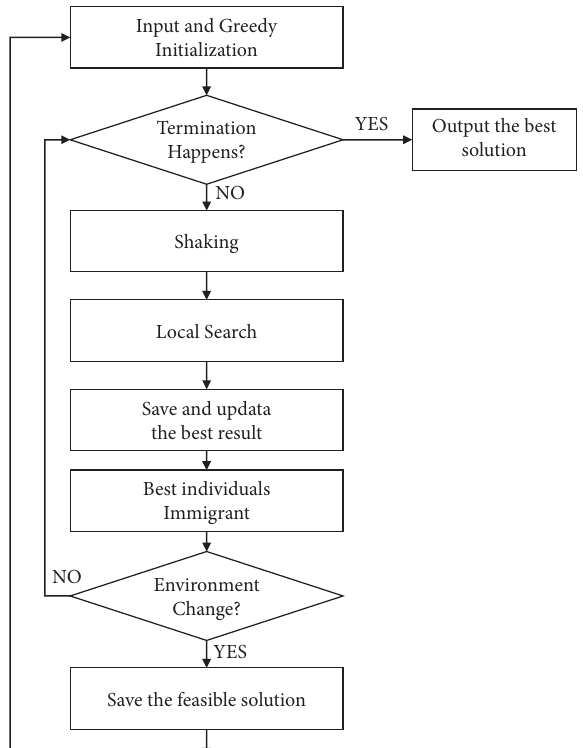
Figure 5: The flowchart of the greedy-initialization VNS with the best population immigrant